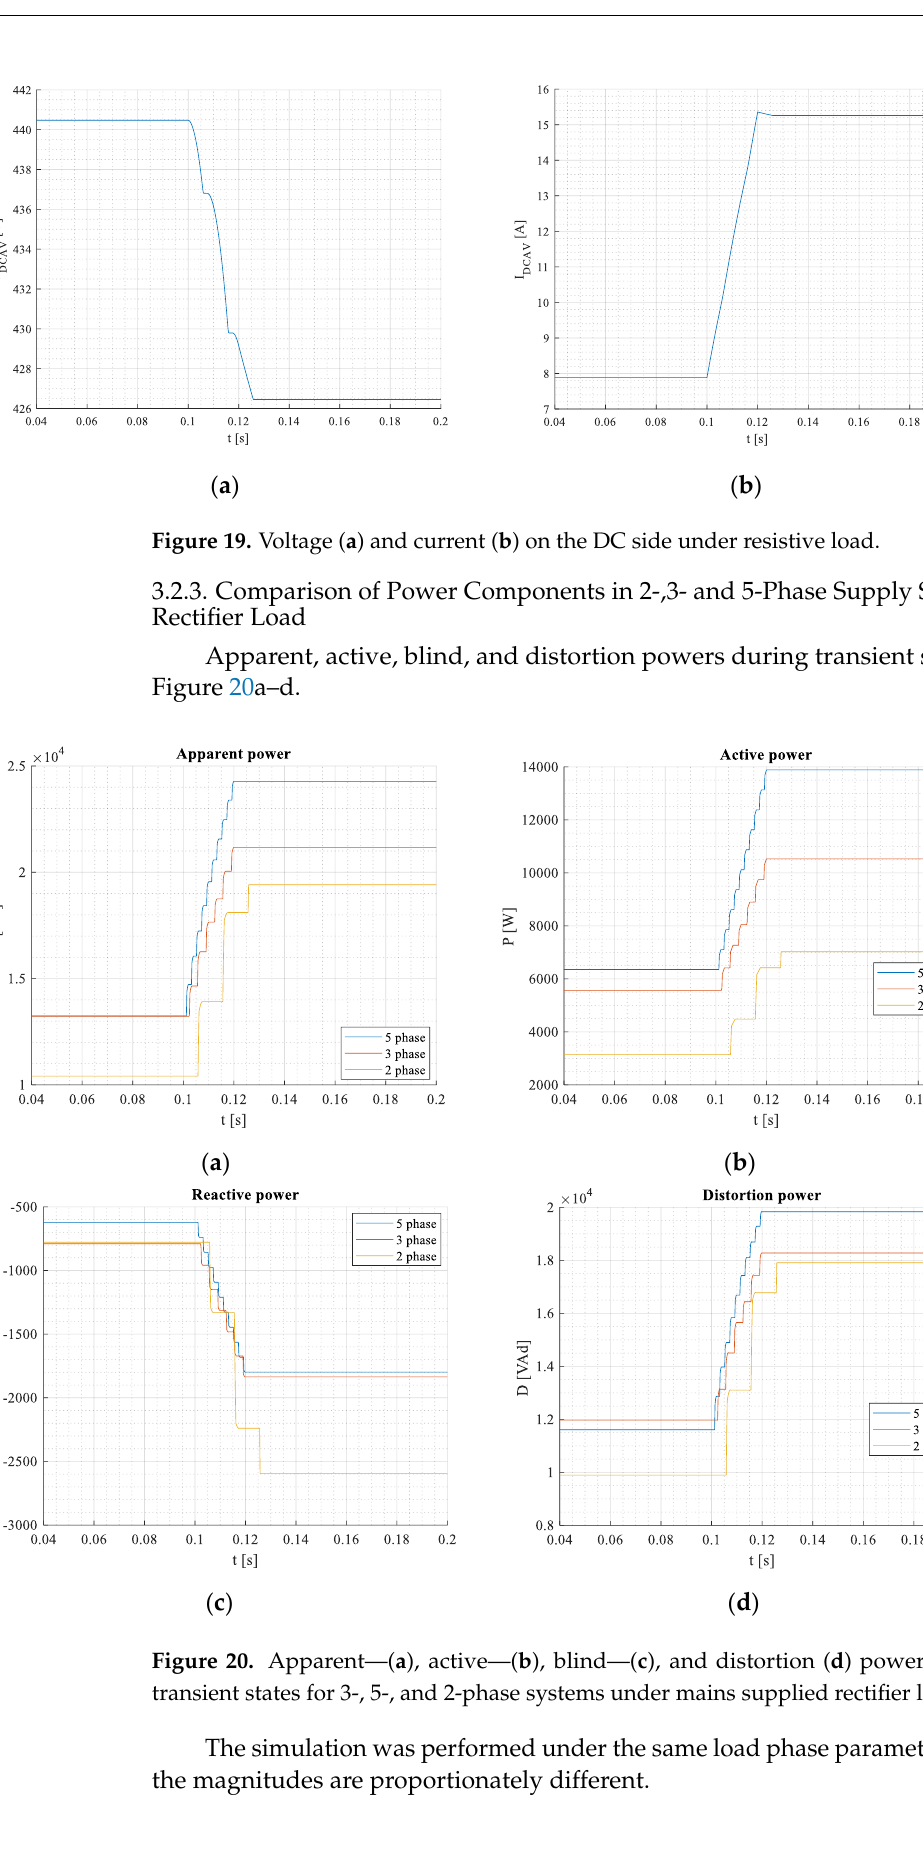
Figure 20. Apparent — ( a ), active — ( b ), blind — ( c ), and distortion ( d ) power components during transient states for 3-, 5-, and 2-phase systems under mains supplied rectifier load. The simulation was performed under the same load phase parameters ( R, C ); therefore, the magnitudes are proportionately